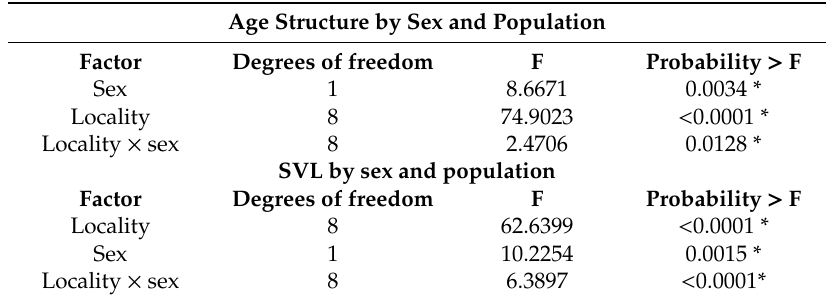
Table 3. ANOVA results of statistical analyses to test di ff erences in age structure and SVL at sexual and locality level. Statistically significant values are indicate by asterisks (*).